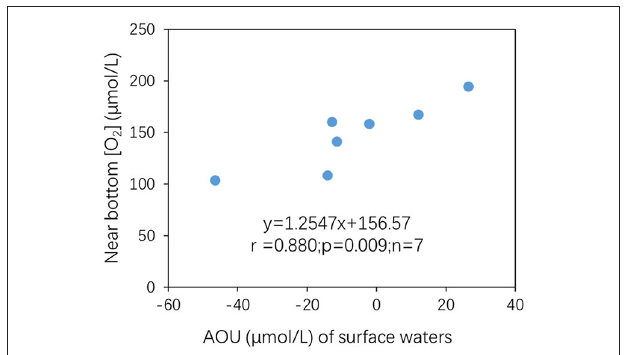
FIGURE 9 | Near-bottom [O 2 ] ( µ mol/L) plotted against AOU ( µ mol/L) in the surface waters.